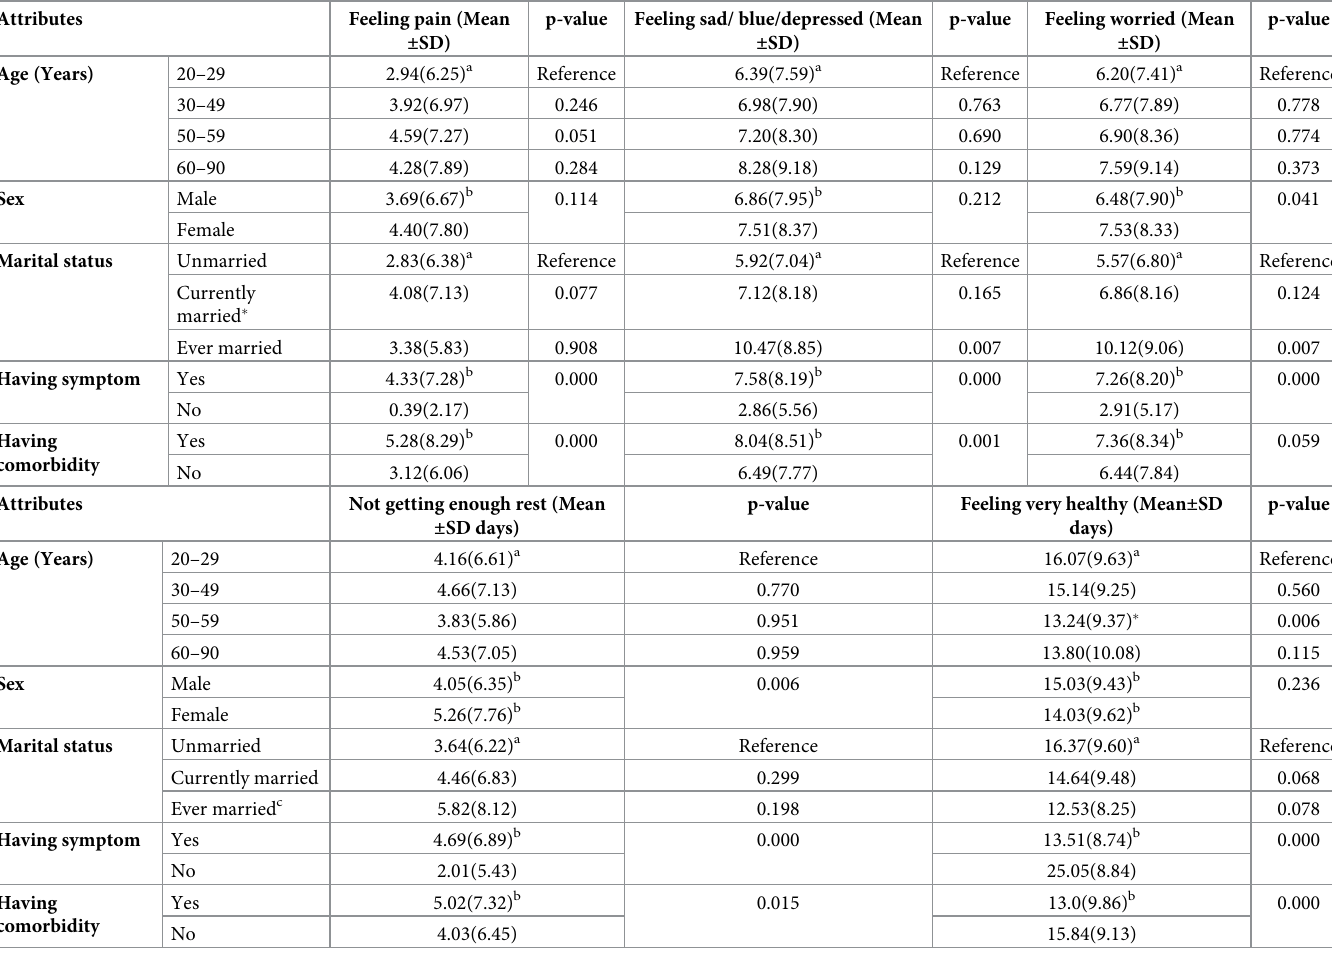
Table 5. Mean( ± SD) duration of selected items of HRQOL by background and clinical attributes of the COVID-19 patients (n =